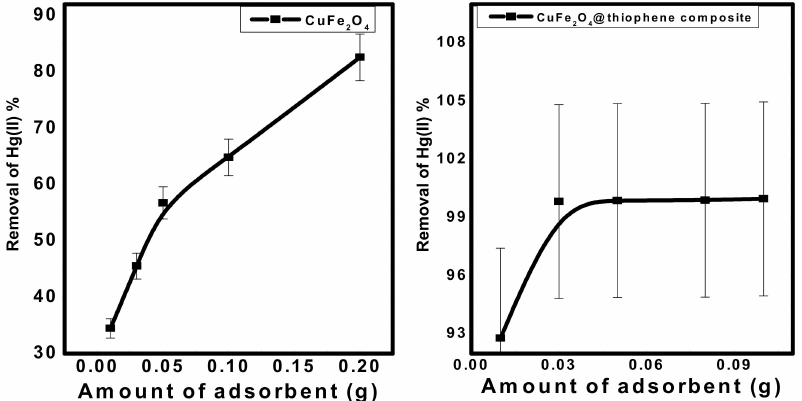
Figure 8. E ff ect of adsorbent dose on Hg(II) removal from aqueous solution. [Conditions: initial conc. of Hg(II) solution = 10 mg / L, contact time = 3 h and 30 min for CuFe 2 O 4 and CuFe 2 O 4 @Polythiophene composite; respectively, pH = 6, volume of Hg(II) solution = 50